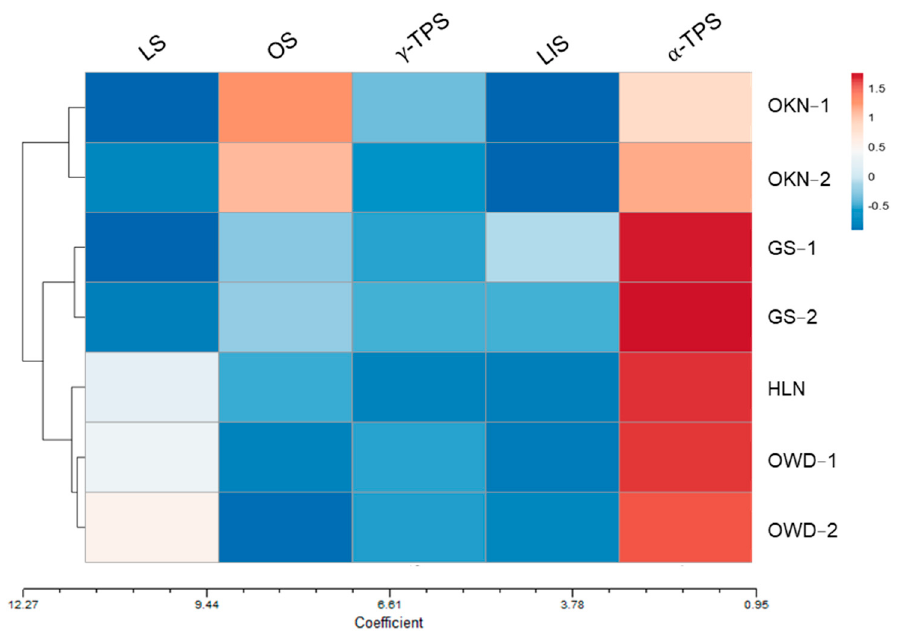
Figure 8. The heatmap of relative gene expression of volatile-compound-synthesis-relevant genes, and the clustering analysis to the accessions of Citrus depressa in Taiwan. Clustering distances for varieties are the Euclidean coefficient, and the clustering method uses the average value. Accessions include OWD-1 and OWD-2 (Ouwanda, Nantou), HLN (Hualien), GS-1 and GS-2 (original sample trees in germplasm), and OKN-1 and OKN-2 (Okinawa, Japan). The gene abbreviations, respectively, represent as follows: LS , gene of limonene synthase; OS , gene of β -ocimene synthase; γ -TPS and α -TPS , genes of γ -terpinene synthase and α -terpinol synthase; and LIS , gene of linalool synthase.